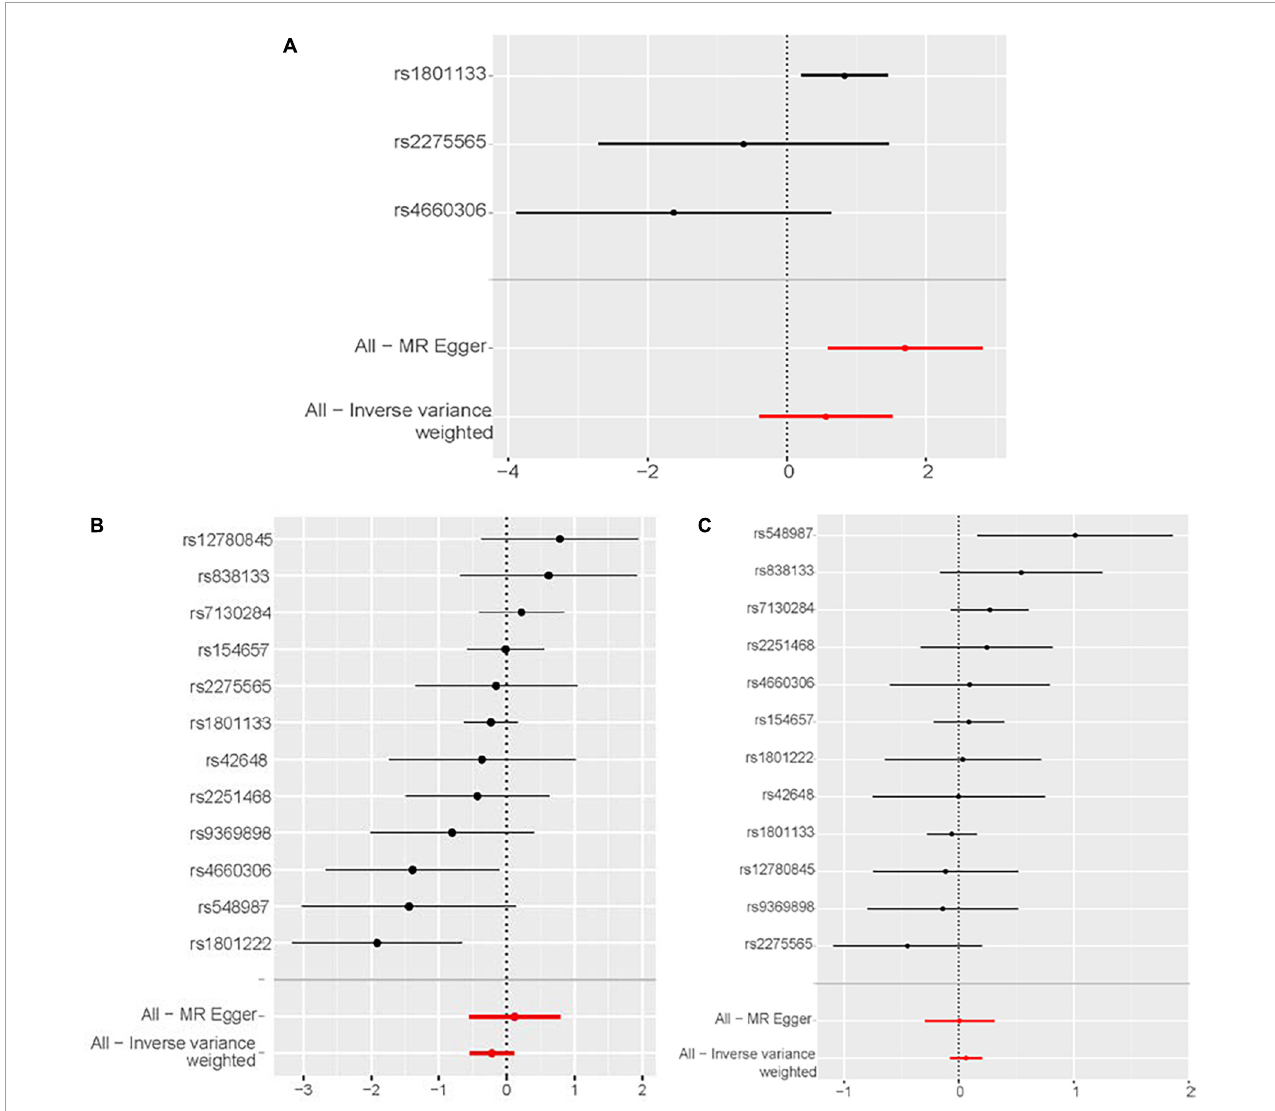
FIGURE4 Forest plot of the potential effects of plasma homocysteine level–associated SNPs on outcomes. (A) Congestive heart failure. (B) Cardiomyopathy. (C) Non-ischemic cardiomyopathy. CI, confidence interval; IVW, inverse variance-weighted; MR, Mendelian